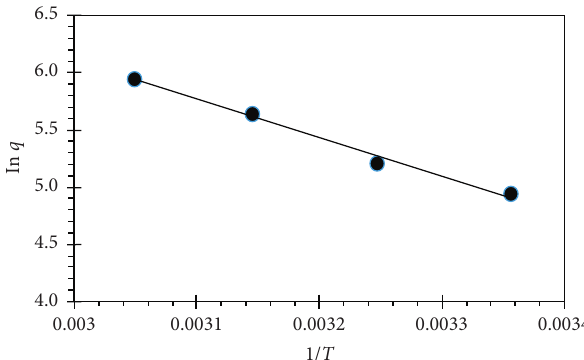
Figure S1: FTIR spectra of the fish bone powder (a) before and (b) after adsorption. Figure S2: Bangham’s diffusion model for Congo red adsorption by fish bone powder ad- sorbent. ( Supplementary Materials )